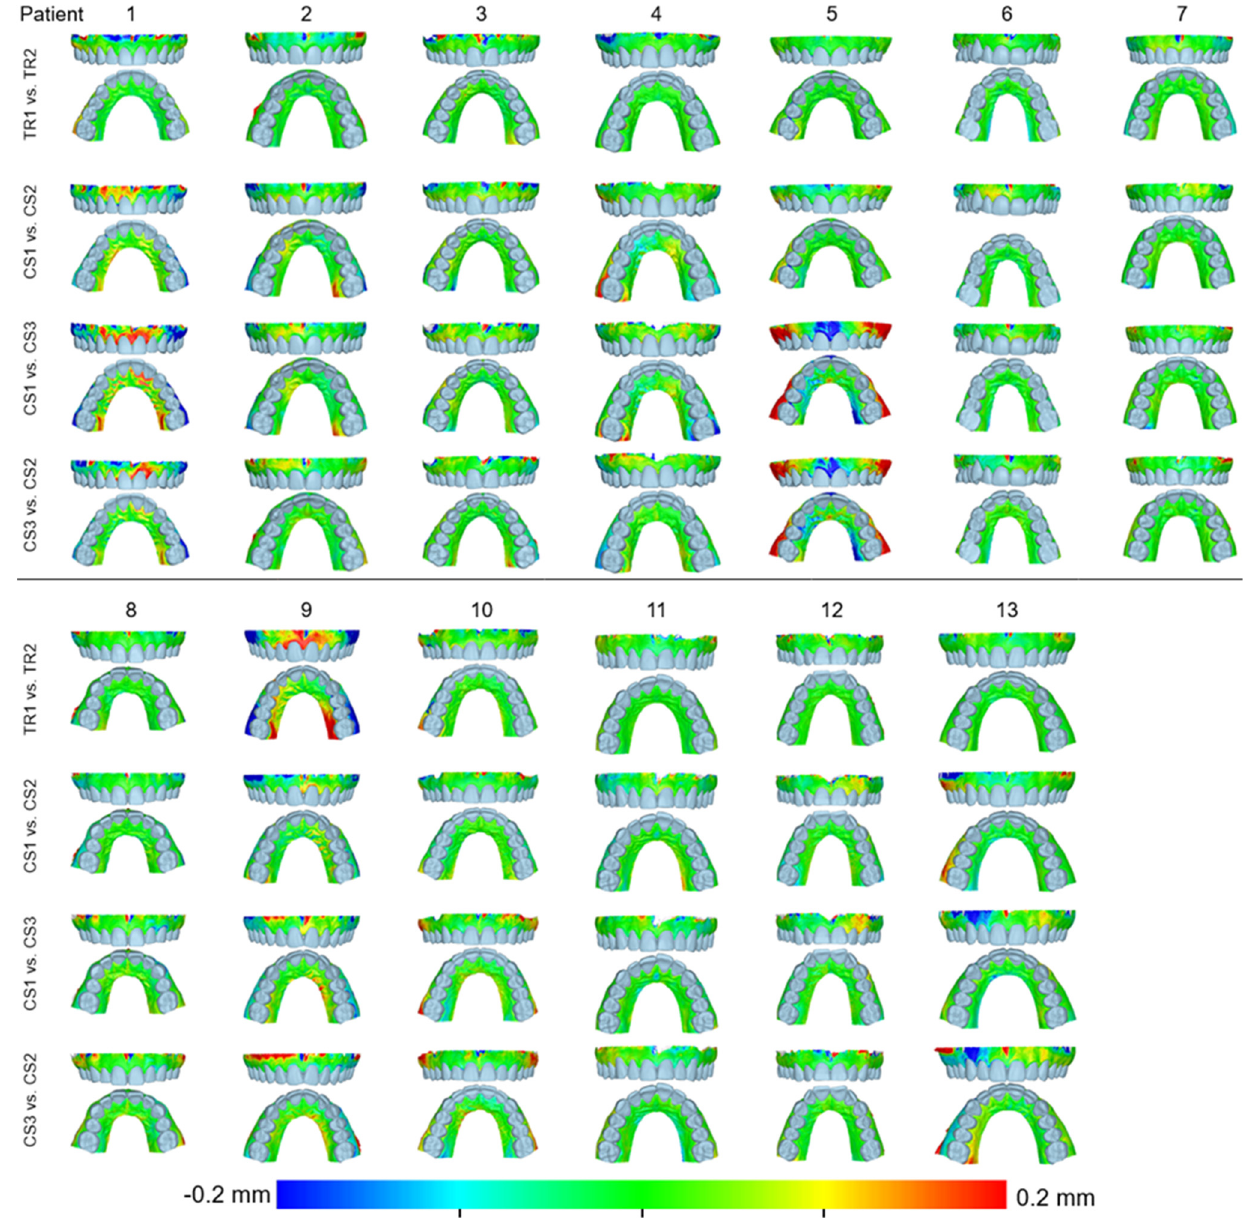
Figure 4. Color-coded distance maps showing the precision of the intraoral scans at the buccal and palatal alveolar soft-tissue surfaces when superimposed on this area. Three scans from CS 3600 (CS1, CS2, and CS3) and two scans from TRIOS3 (TR1 and TR2) were assessed.